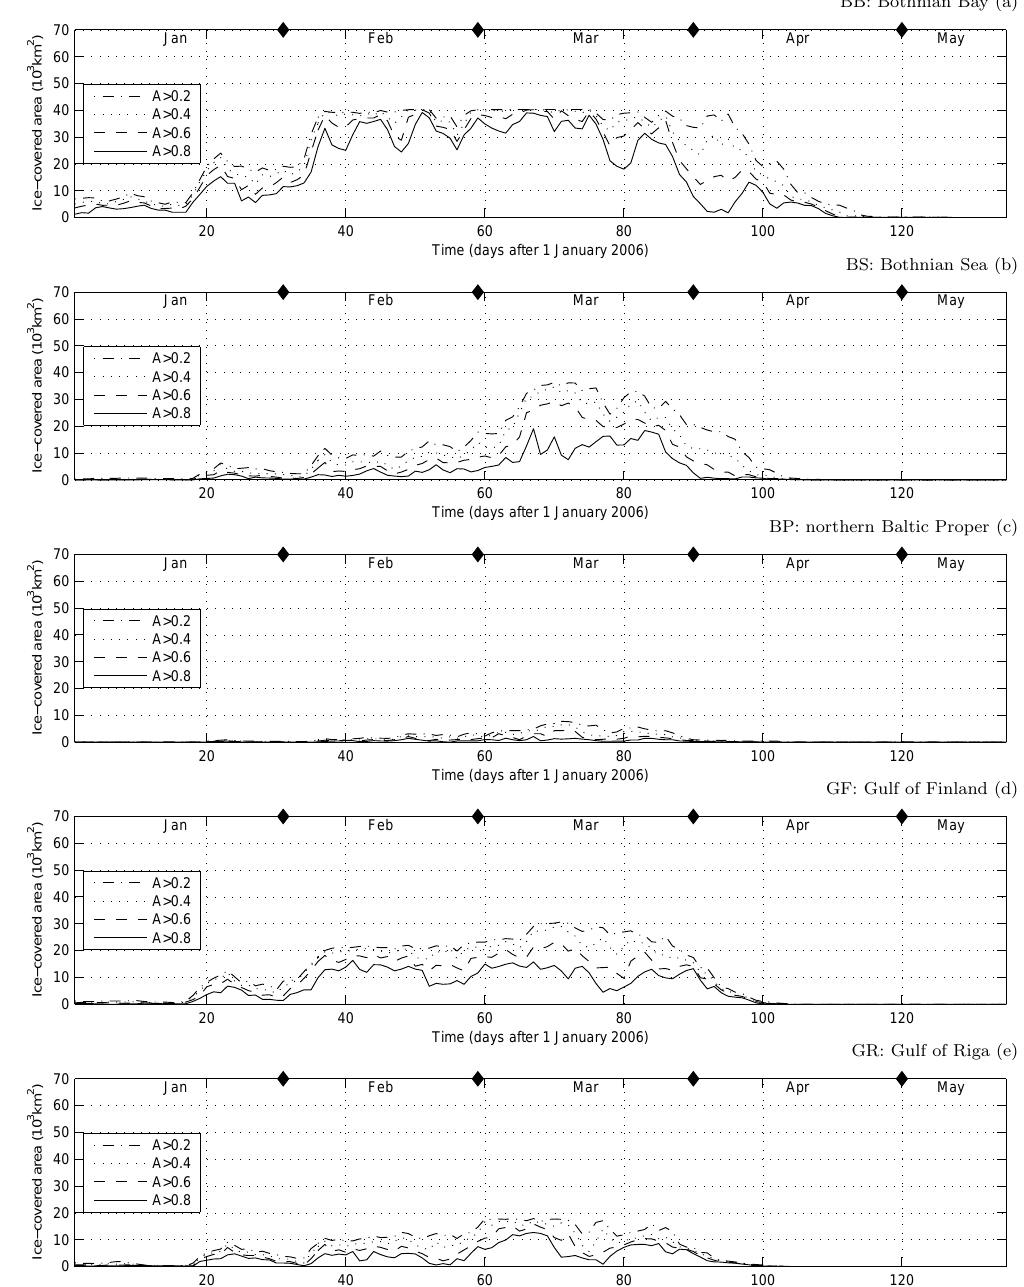
Fig. 4. As in Fig. 3, but for the simulated sea ice